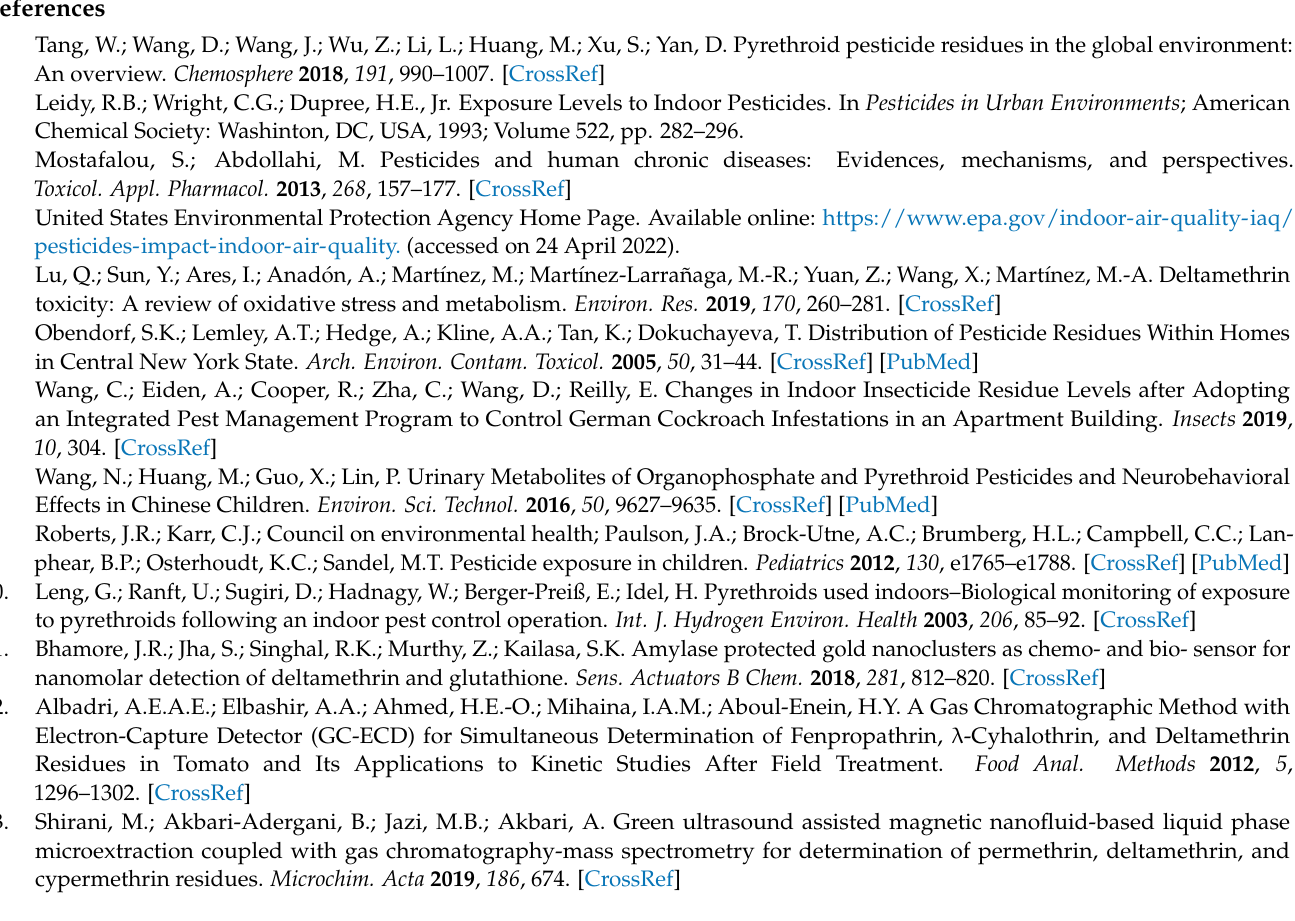
of Ag NPs, KI and DM; Figure S4. The SERS performance of commercial DM product diluted with methanol; Figure S5. Standard curve of deltamethrin for HPLC. The concentrations of DM were 1 ppm, 2 ppm, 3 ppm, 5 ppm, 10 ppm, respectively. The fitting equation was y = 0.332 + 7.360 × (R2 = 0.990); Figure S6. The diagram of setup for surface residue analysis; Table S1. The assignment of SERS peaks of DM with Iodide assisted Ag NPs FSM sensor; Table S2. Statistical results of the SERS signal of eight Ag NPs FSMs; Table S3. Analysis of the variance of results of SERS and HPLC method (n =